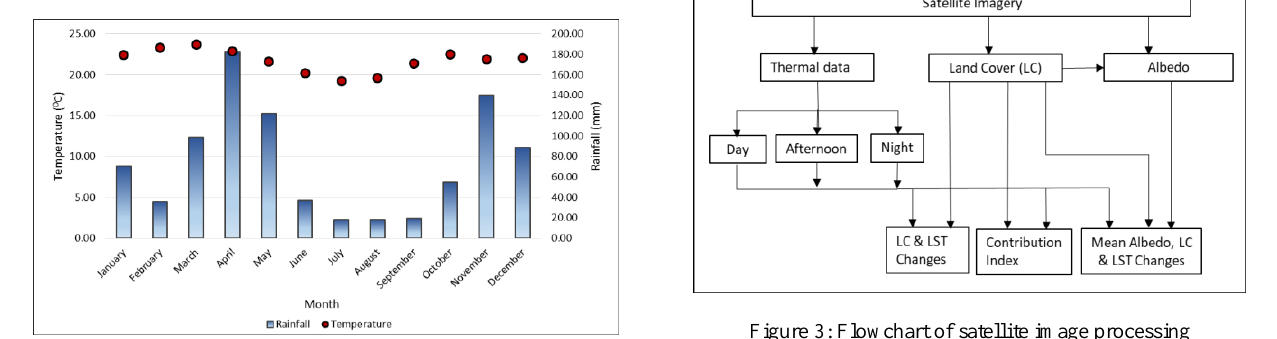
Figure 3: Flowchart of satellite image processing